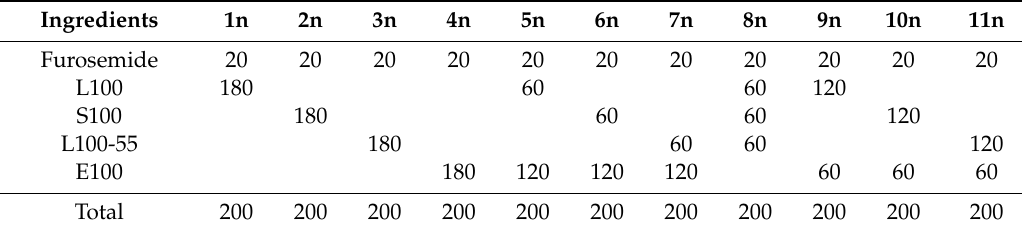
Table 1. Composition (in mg) of nanofiber tablets of formulations